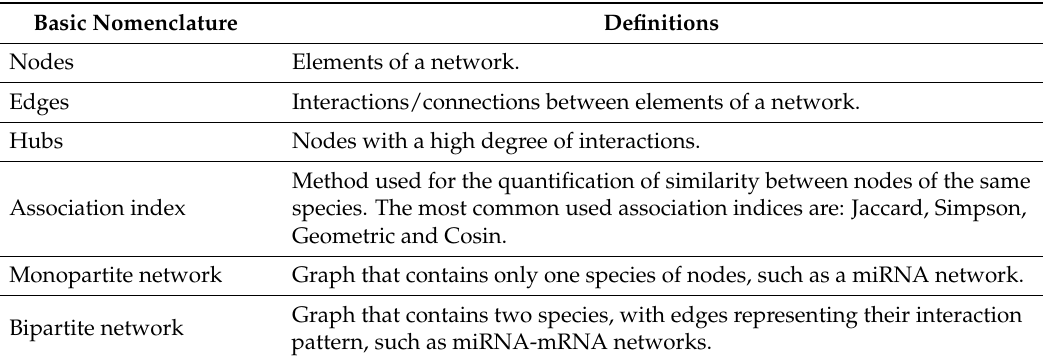
Table 1. Definitions of network components and types of